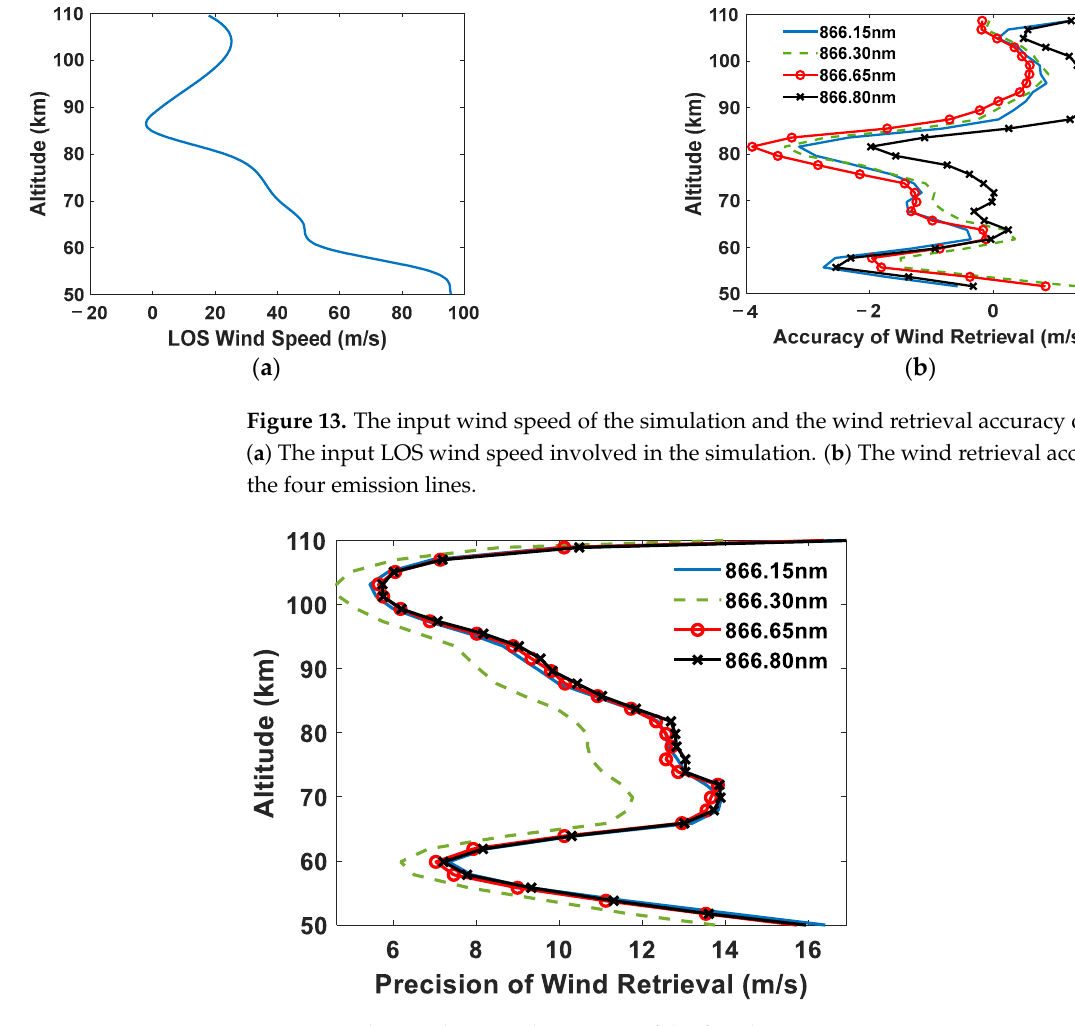
Figure 14. The wind retrieval precision of the four lines.